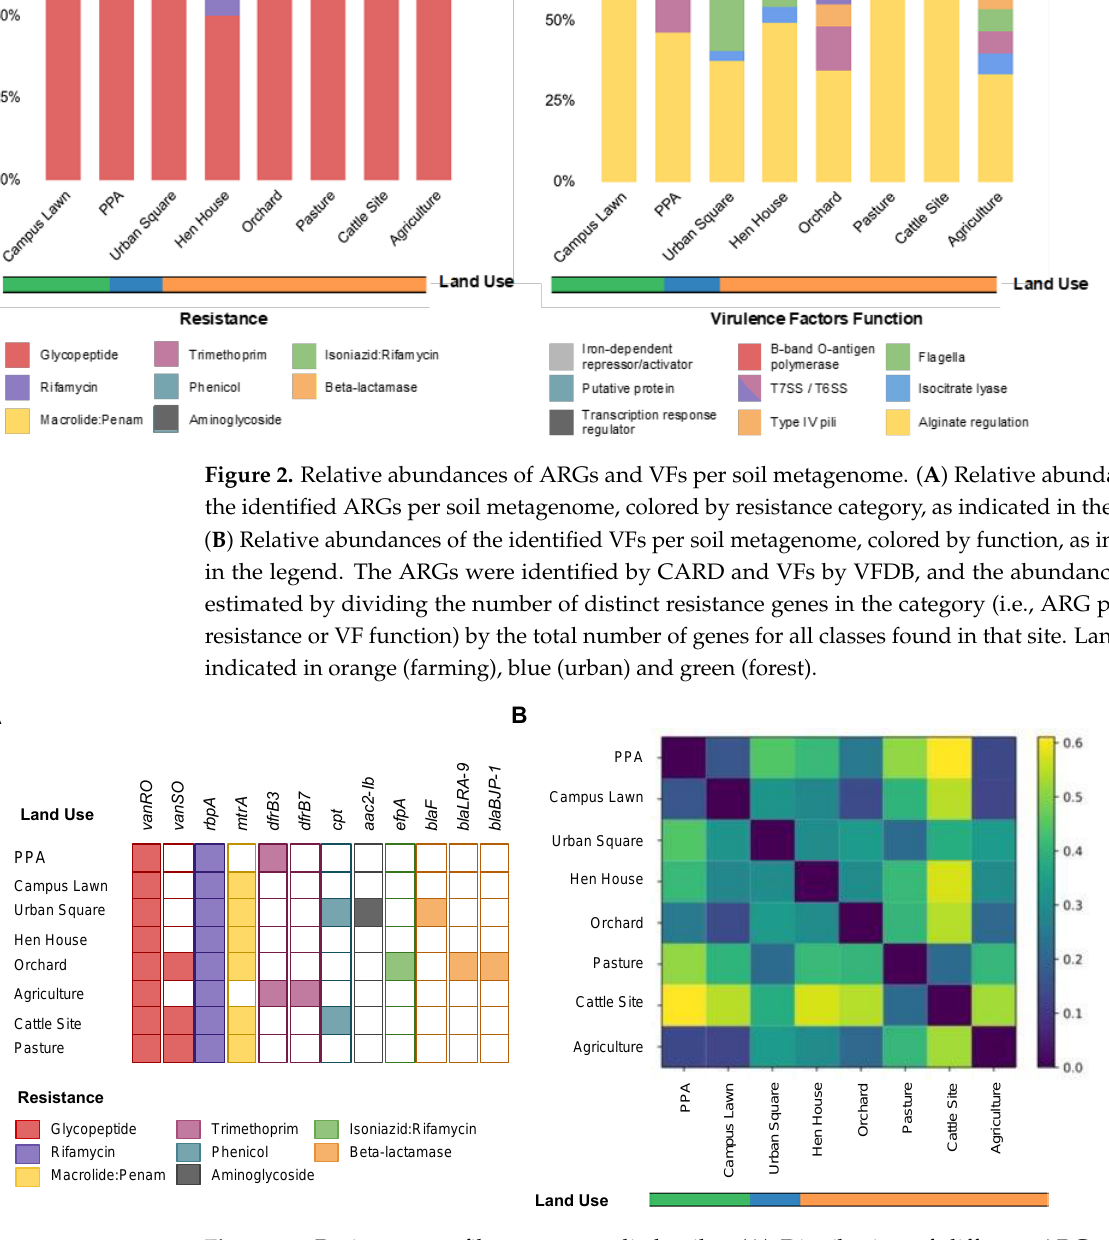
Figure 3. Resistome profiles across studied soils. ( A ) Distribution of different ARGs per soil metagenome, colored by resistance category, as indicated in the legend. The absence of color indicates the absence of occurrence of the ARG in the soil. ( B ) Heatmap showing the (dis-)similarity between two soil resistome profiles using Bray–Curtis distance. The purple to yellow scale (0–0.6) indicates the degree of dissimilarity between the ARGs’ relative abundances in two soils, as indicated in the legend. Land use is indicated in orange (farming), blue (urban) and green (forest).